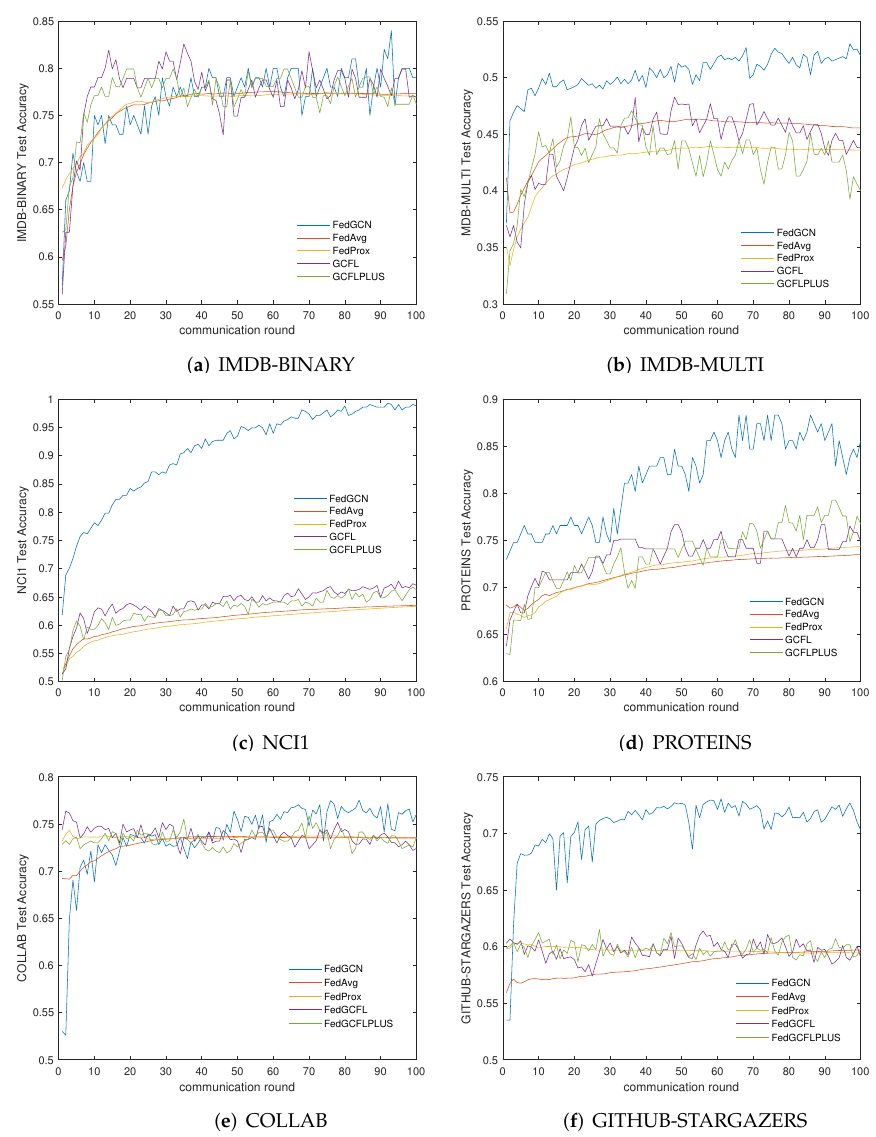
Figure 9. Comparison of the accuracy of federated learning algorithms. The advantages of FedGCN can also be clearly seen from Table 3. The table lists the average accuracy of the global model obtained by each algorithm after 100 rounds of communication on different data sets and the highest accuracy in 100 rounds. To a certain extent, the average accuracy can show that FedGCN has a higher accuracy in most communication rounds, and the highest accuracy can represent the best processing performance of FedGCN. These processes benefit from the fact that FedGCN has a good local model, which can not only fully extract the features of the graph structure data, but also fine processing for each client to customize the aggregation weights suitable for each local